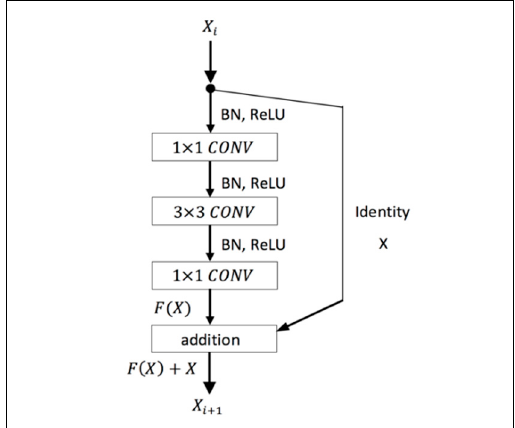
Figure 4. Building block in residual learning.